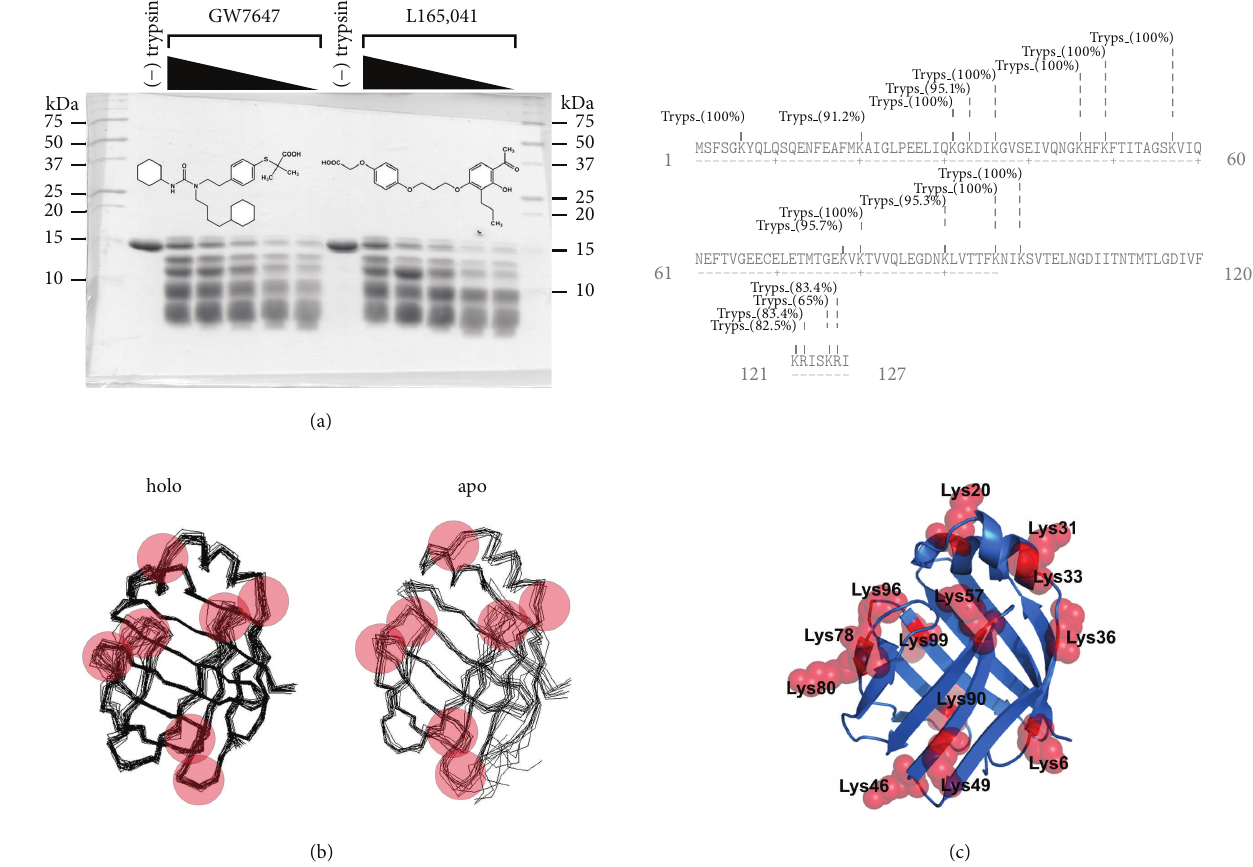
Figure 3: Binding to PPAR selective drugs protects L-FABP from limited proteolysis. (a) L-FABP was preequilibrated with increasing concentrations (0, 0.1, 0.4, 1.0, 5 𝜇 M) of GW7647 or L165,041 and then digested with trypsin. The resultant fragments were resolved on 20% polyacrylamide gels and visualized by Coomassie Blue G250 staining. Molecular weight standards are indicated on the ordinate. (b) The red spheres highlight the predicted tryptic cleavage hot spots on backbone overlays of the ensemble of structures determined by solution-state NMR for apo- (PDB code: 2PY1) and holo- (PDB code: 2L68) human L-FABP. (c) Top panel, tryptic cleavage sites predicted by the ExPASy PeptideCutter algorithm mapped onto the amino acid sequence of human L-FABP. The probability of cleavage at each site is indicated in parentheses. Bottom panel, the highest scoring sites ( > 90% probability) are mapped onto the crystallographic structure of human L-FABP (PDB code: